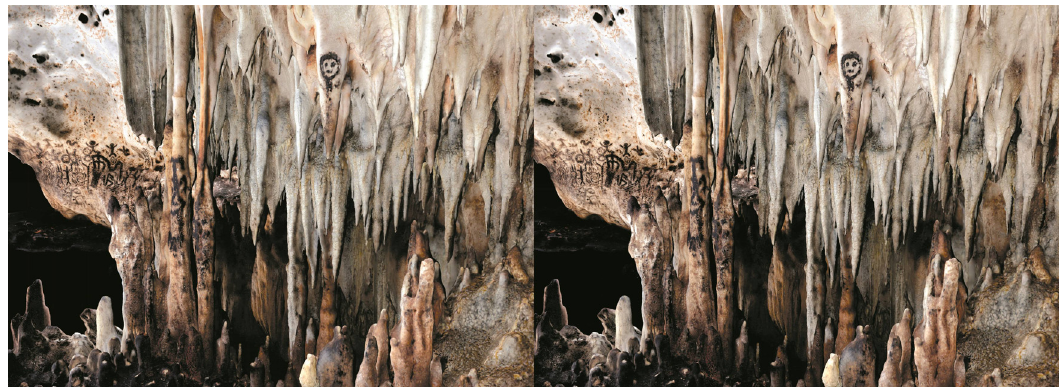
Figure 10: Stereoscopic images of José María cave used for 3D short movies ( slides obtained from the 3D model ) .